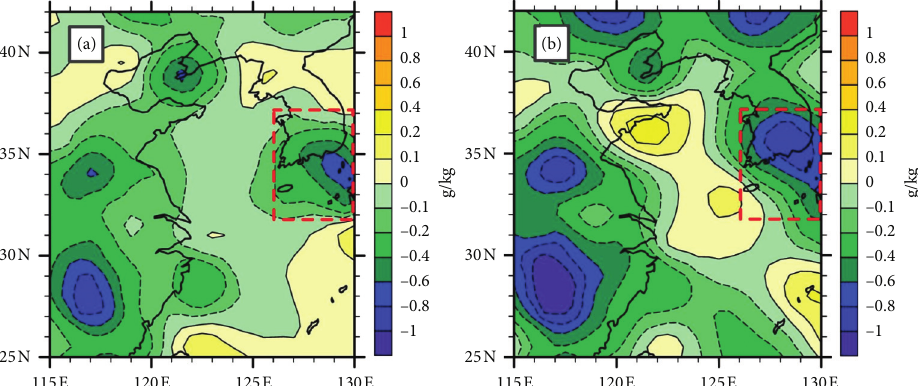
Figure 16: Analysis increments of mixing ratio in Exp-B_CV5 (a) and Exp-B_CV6 (b) near the surface. The area framed by a red-dashed line box is named